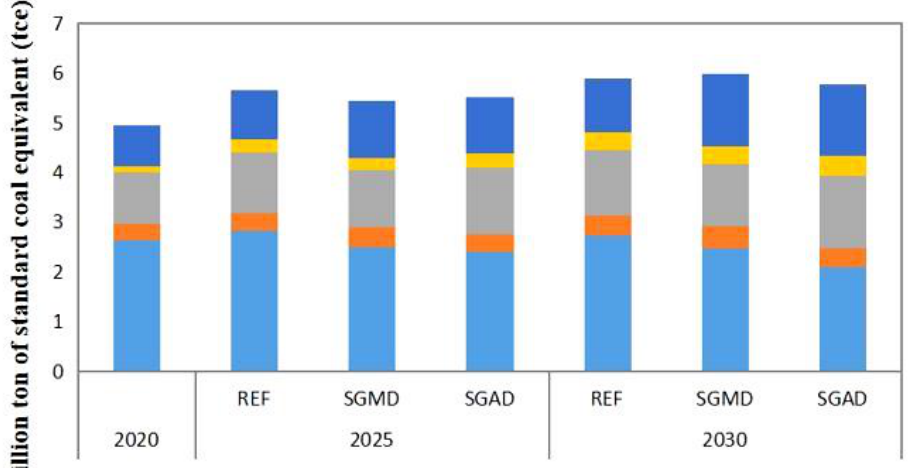
Figure 6. Primary energy consumption.